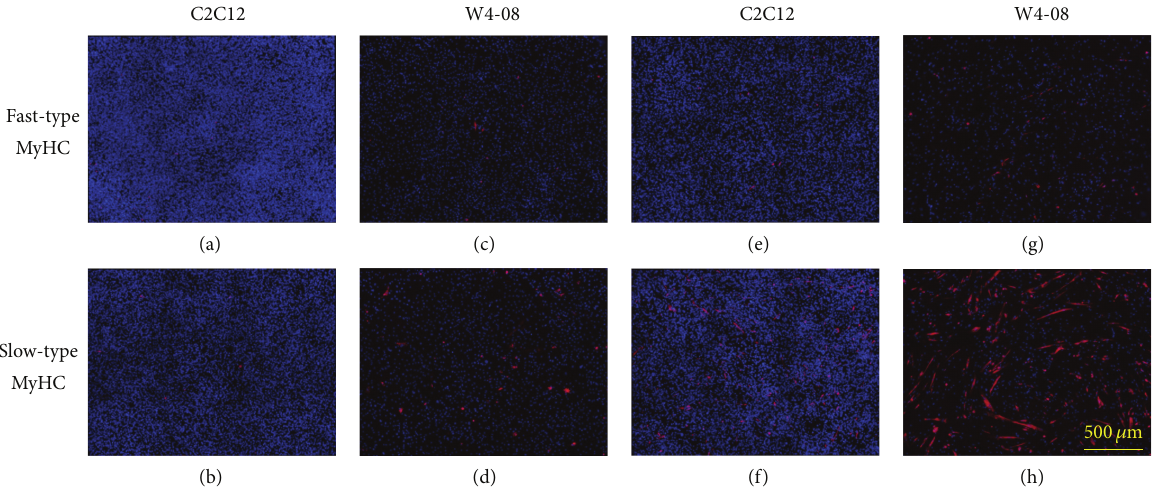
Figure 1: Myosin heavy chain (MyHC) expression in parental C2C12 cells and C2C12-derived cells permanently expressing Wnt4. Parental C2C12 cells (a, b, e, and f) and W4-08 cells (c, d, g, and h) were cultured for 2 days in proliferation medium containing 10% fetal bovine serum (a–d), or in differentiation medium containing 2% horse serum (e–h), and then immunohistochemically stained with anti-MyHC antibodies, followed by counterstaining with DAPI. Spontaneous expression of slow-type MyHC was evident in W4-08 cells in proliferation medium and intensified in differentiation medium, although the proliferation rates were greatly reduced compared to those of the parental C2C12 cells, as observed in the reduced number of nuclei (blue).